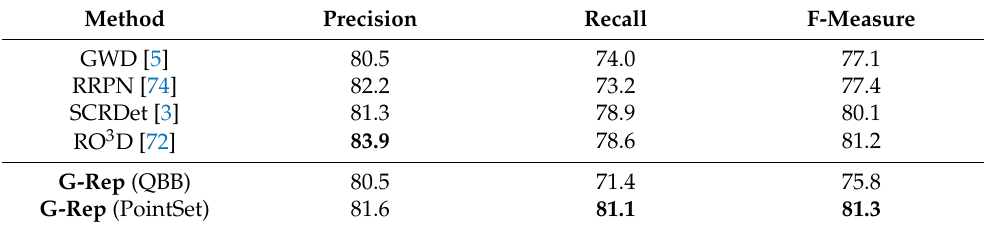
Table 10. Comparison of the performance of different methods on ICDAR2015.